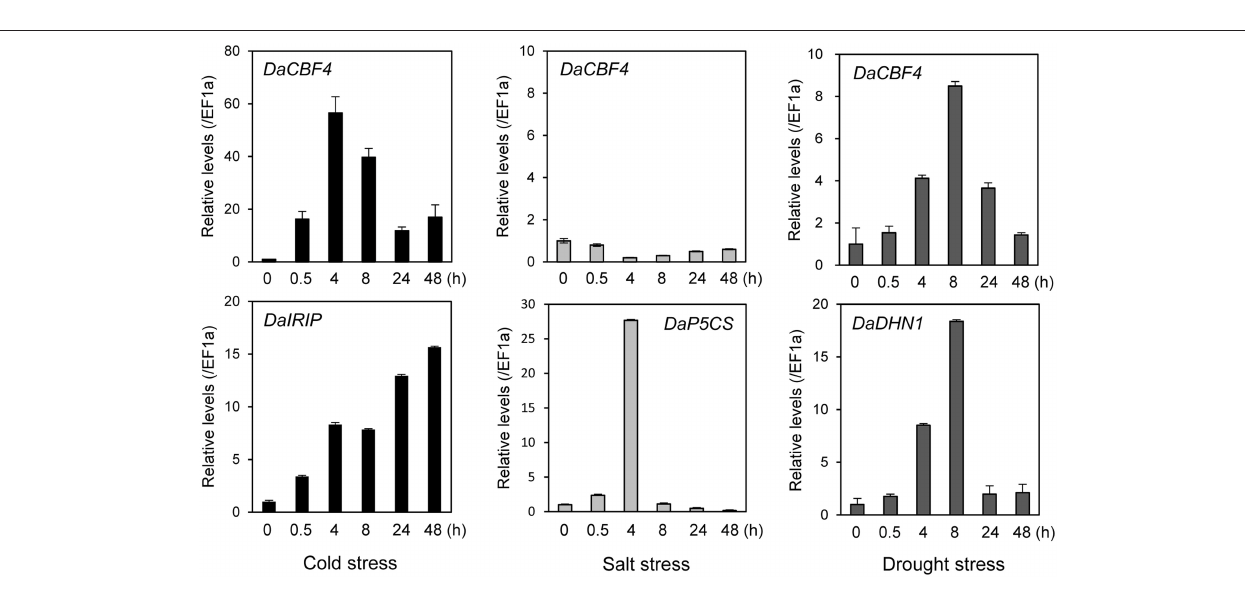
Frontiers in Plant Science |